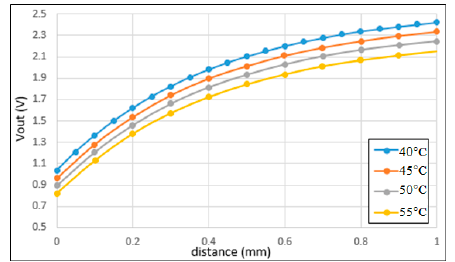
Figure 10. Correlation between output inductive voltage and sensing distance for working temperatures in the range of 40~55 °C.